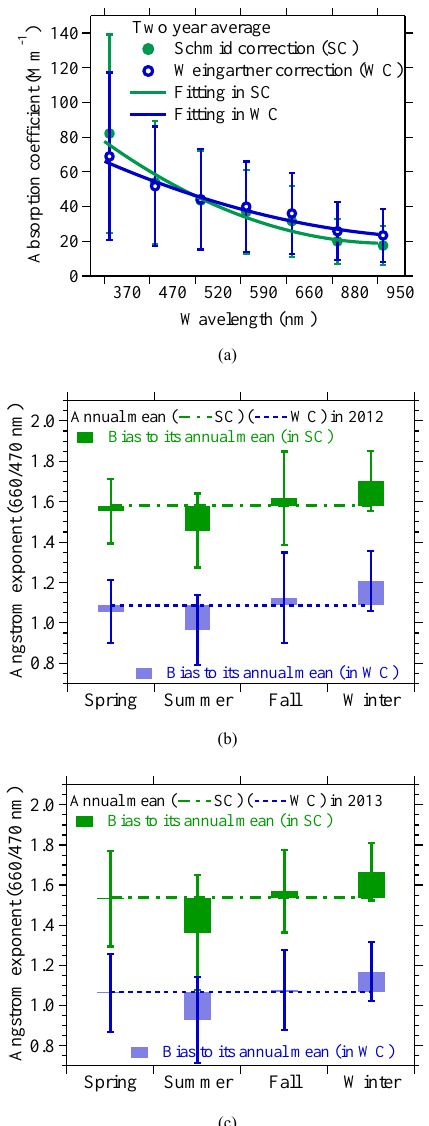
Figure 7. Dependence of the aerosol absorption coefficient cor- rected by WC2003 (blue) and SC2006 (green) on the wavelength in the urban area of Nanjing during the period from 2012 to 2013 (a) . Annual (dash lines) and seasonal (bars with error bar) absorption Ångström exponents at 660/470nm from WC2003 (light blue) and SC2006 (green) both in 2012 (b) and 2013 (c)